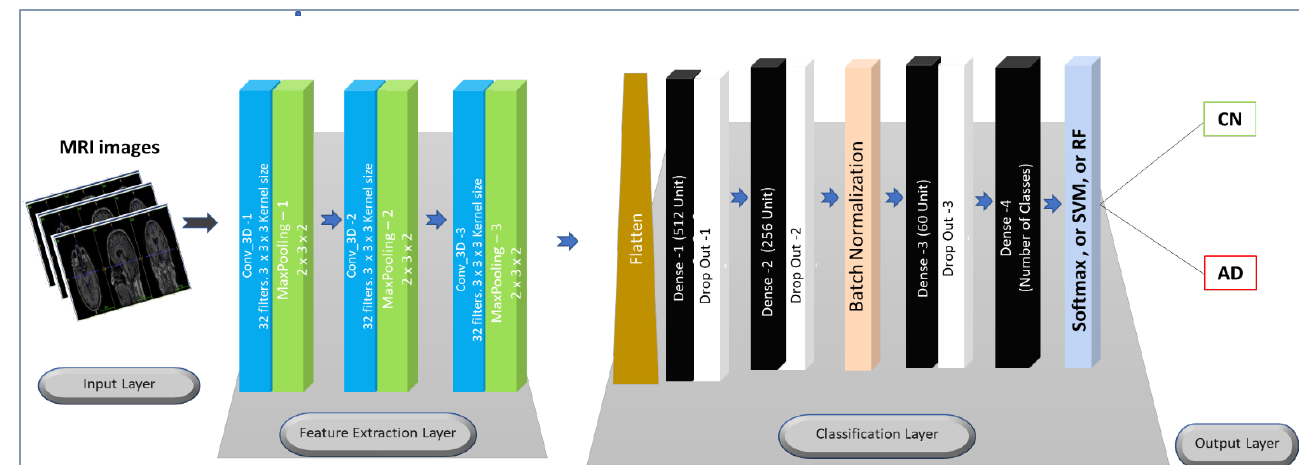
Figure 11. The proposed 3D-CNN architecture.